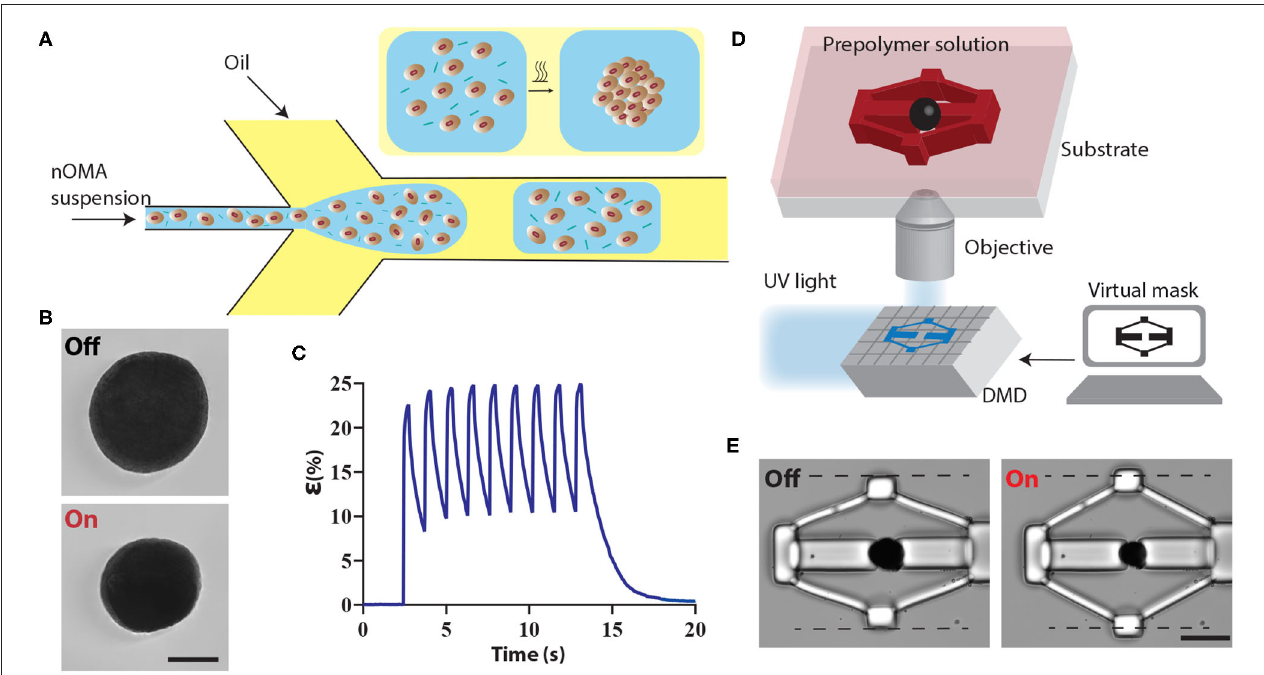
FIGURE 1 | Fabrication and operation of machine components. (A) Schematic illustration of the microfluidic colloidal assembly process. An aqueous solution of nOMAs and crosslinker forms the discontinuous phase while the continuous phase comprises the surfactant and oil mixture. The emulsion was collected and heated overnight to facilitate the crosslinking process. (B) A representative example showing the fully contracted state of a µ OMA upon NIR illumination. The laser power on the sample was adjusted to 10 mW. Scale bar, 100 µ m. (C) Actuation strain vs. time plot for a 15 mW NIR signal with 260 ms pulse duration at 0.8 Hz. (D) The fabrication methodology for building compliant flextensional mechanisms. The projector defines the geometry of the structures polymerizing around the actuators. (E) Snapshots from the actuation of a representative mechanism. Scale bar, 50 µ